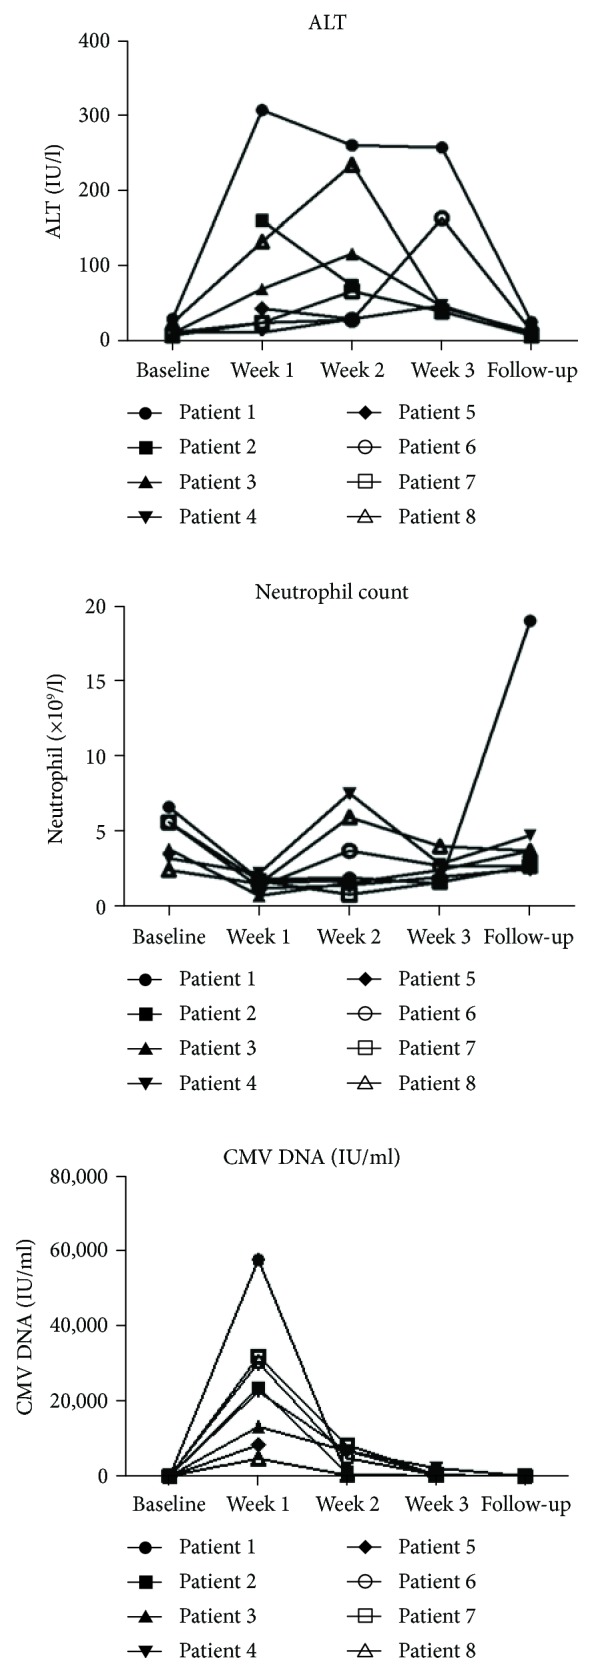
Trend in alanine transferase (ALT) (IU/ml), neutrophil count (×109/l) and CMV DNA (IU/ml) over time from baseline to time of the last follow-up.